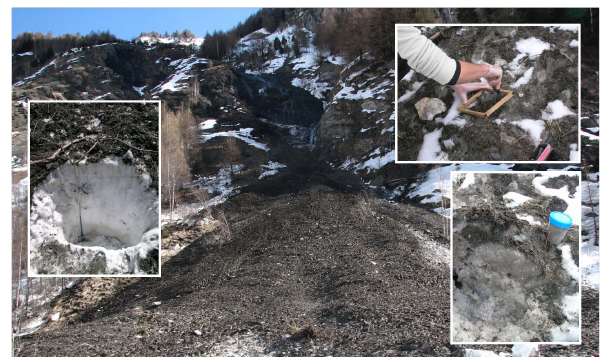
Fig. 2. Snow deposit in the Lower Deposition Area (LDA): 2008– 2009 avalanche event. On the right a particular of the sampling method for the deposit surface (top) and for the sub-superficial snow (bottom); on the left the pit dug into the